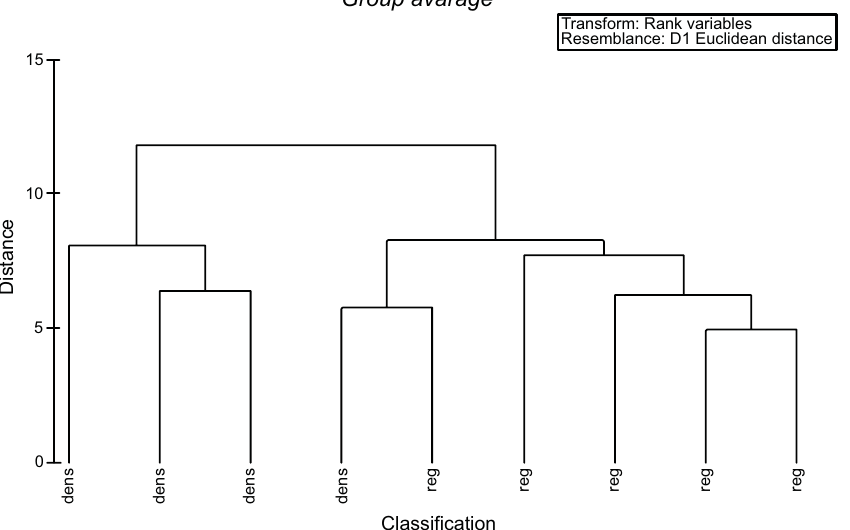
Figure 3. The result of cluster-analyses (PAHC) of vegetation data and demographic data of Alluaudia procera from plots 20 6 20 m in regenerating (n=5) and dense mature forests (n=4) in northern central Androy. The distance is based on average group linkages. Variables included in the model: height, diameter, proportion of juveniles ( , 2 m) of Alluaudia procera and abundance estimates of woody species . 1 m height. The analysis was used for validation of the forest classification in the Landsat images.